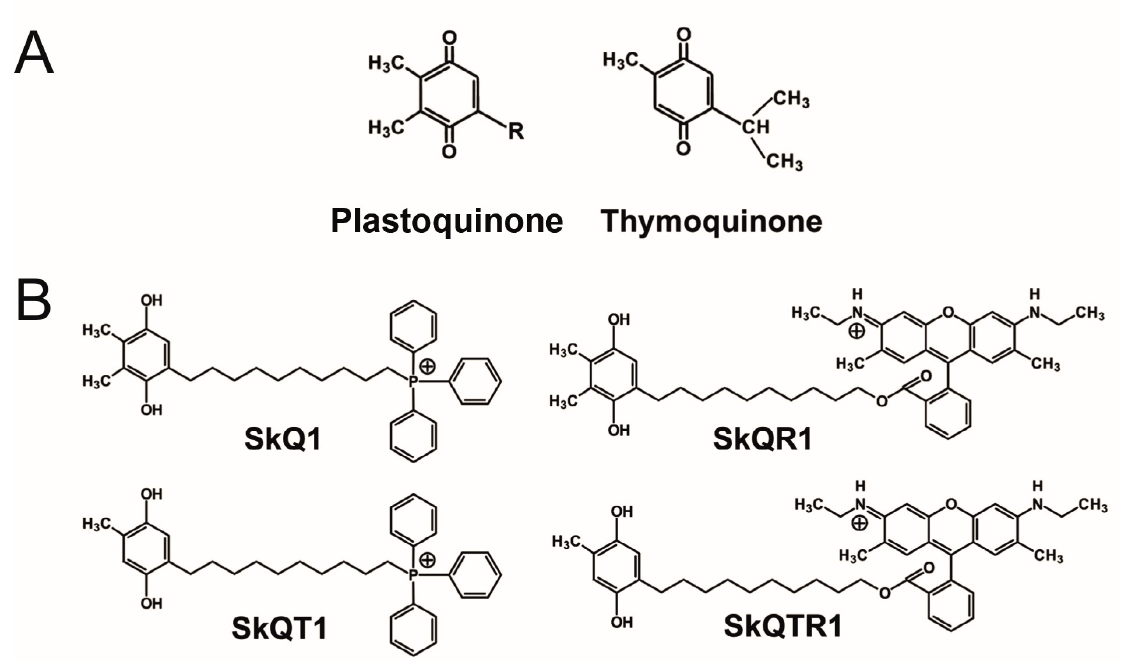
Figure 1. Chemical structure of compounds used in the study. ( A ) The compounds of plant origin, based on which mitochondria-targeted antioxidants were synthesized. R- nine isoprenyl units; ( B ) Chemical structures of: 10-(6 ′ -plastoquinonyl) decyltriphenylphosphonium (SkQ1); 10-(6 ′ -toluquinonyl) decyltriphenylphosphonium (SkQT1); 10-(6 ′ -plastoquinonyl) decylrhodamine 19 (SkQR1); 10-(6 ′ -toluquinonyl) decylrhodamine 19